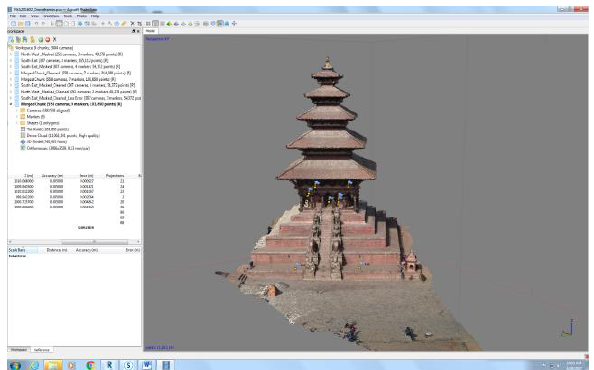
Figure 4. Aerial photogrammetry model using UAV